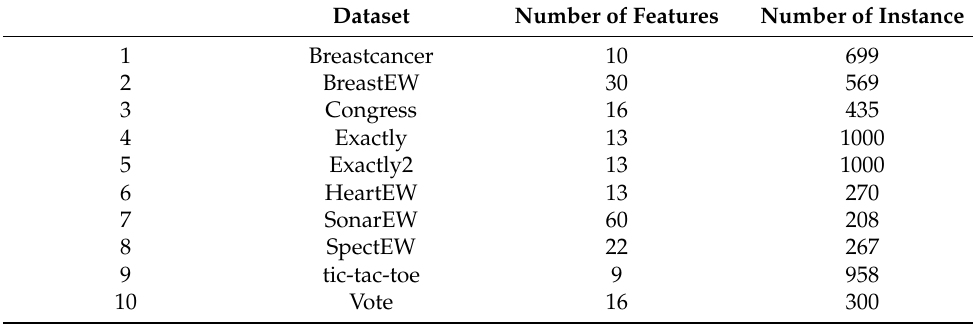
Table 1. Datasets.